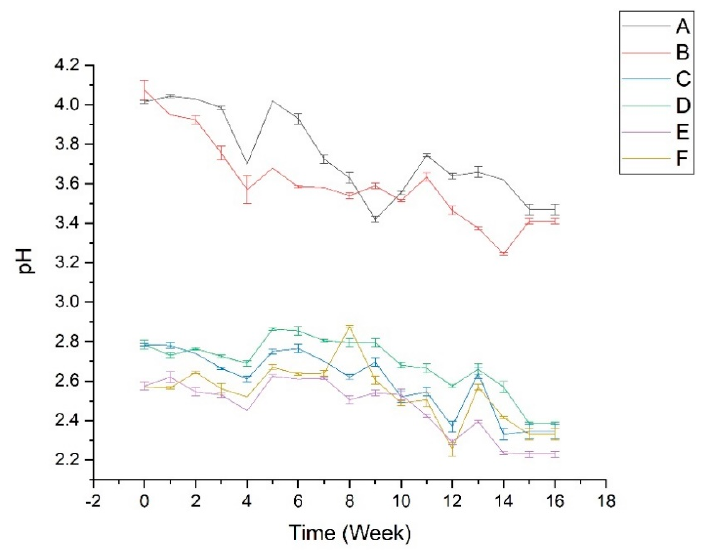
Figure 1. pH measurement of all stability test samples. The details of sample code refer to Table 1.